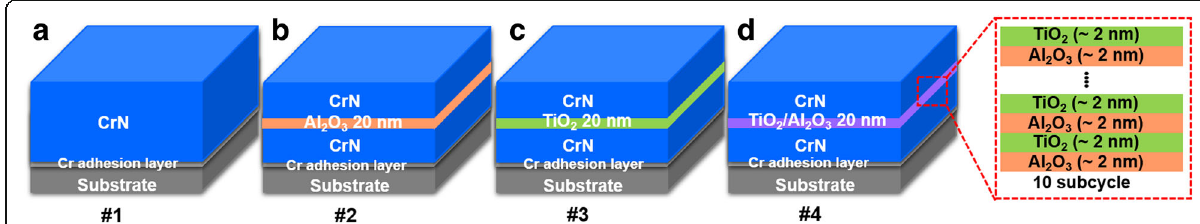
Fig. 1 Schematic illustrations of the cross-sectional structure. a Pure CrN coating. b CrN-Al 2 O 3 ; CrN coating with a 20 nm Al 2 O 3 sealing layer. c CrN-TiO 2 ; CrN coating with a 20 nm TiO 2 sealing layer. and d CrN-Al 2 O 3 /TiO 2 ; CrN coating with a 20 nm nanolaminate-Al 2 O 3 / TiO 2 sealing